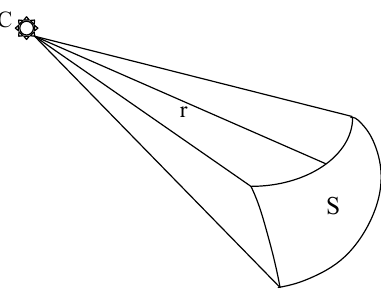
Figure 13. Schematic of light source.